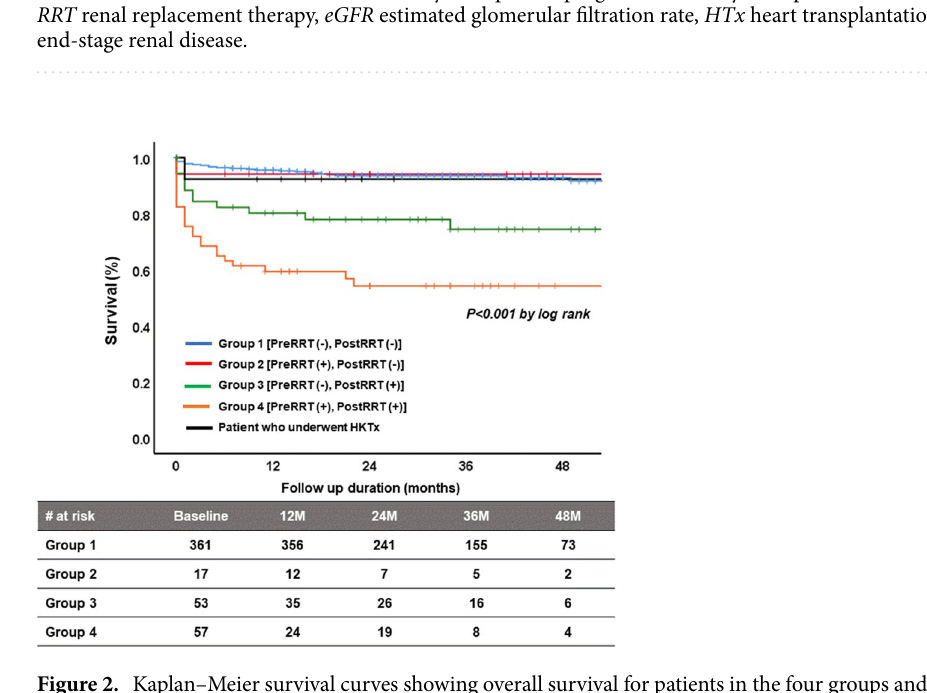
Figure 2. Kaplan–Meier survival curves showing overall survival for patients in the four groups and those who underwent combined HKTx. RRT renal replacement therapy, HKTx heart and kidney